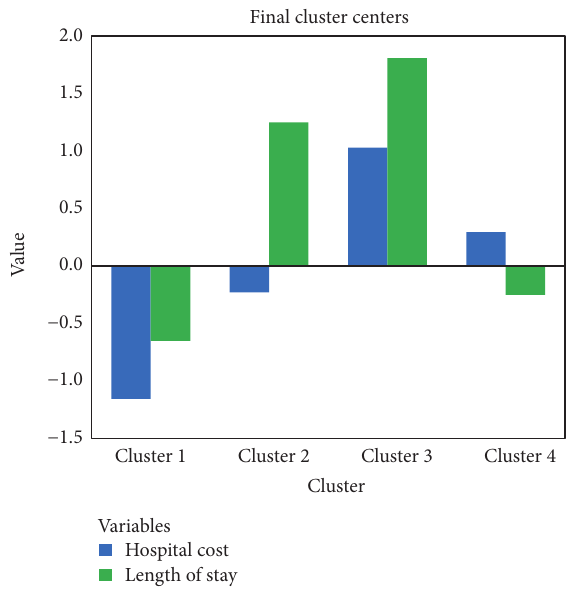
Figure 3: Cluster with nonsurgical